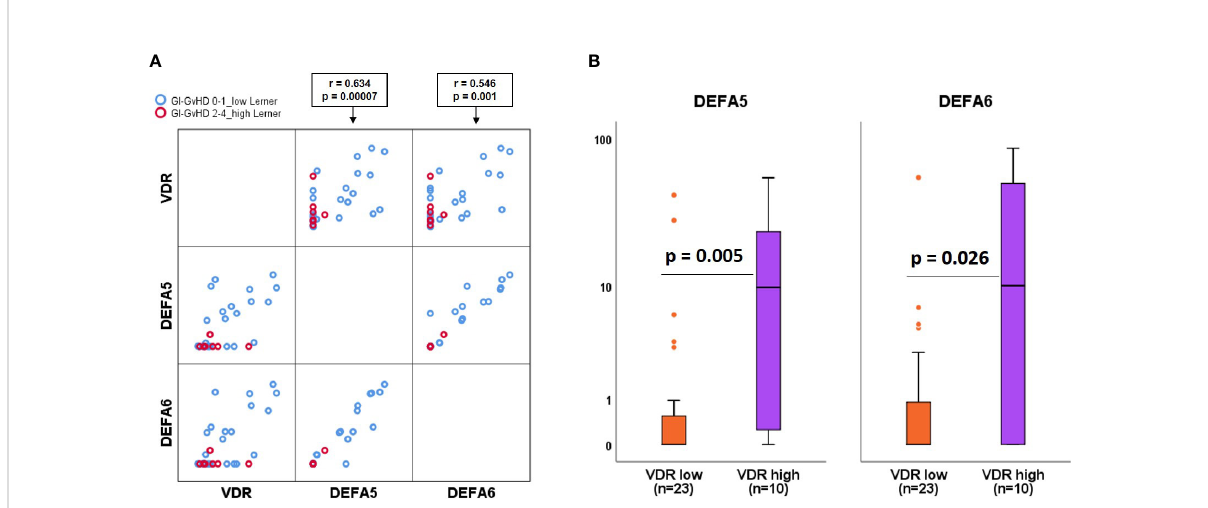
FIGURE 4 Association of anti-microbial peptides with VDR. (A) Matrix scatter correlation plot of VDR, DEFA5, DEFA6 genes within low (blue circles) and high (red circles) Lerner GvHD. (B) Comparison of alpha defensins gene expression in patients with low versus high VDR gene expression. Box plots represent median, upper and lower quartile and whiskers indicate minimal and maximal values. r value, Spearmann correlation coef fi cient. p value, Mann-Whitney U